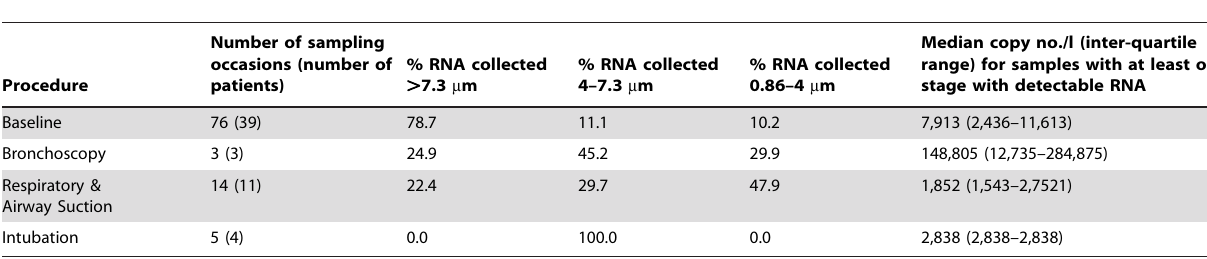
Table 3. The % of RNA collected from each procedure in each stage of May